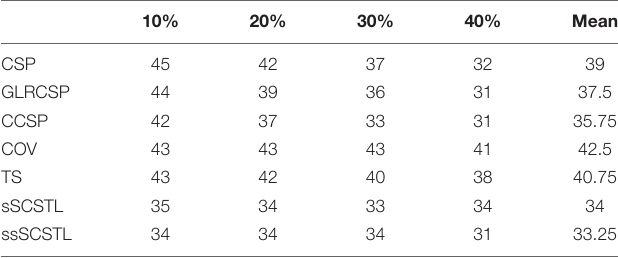
and ssSCSTL stood out themselves on average. However,